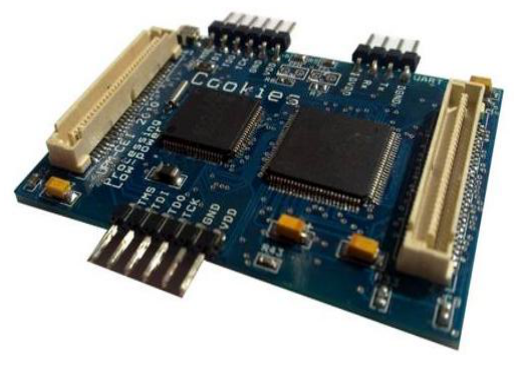
Figure 13. MSP430 cookie processing layer.